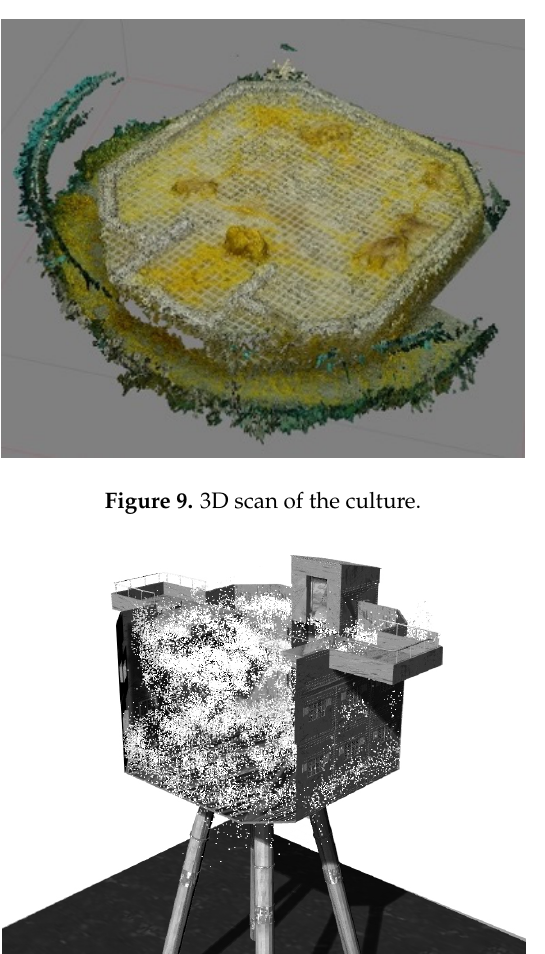
Figure 8. Documentation process of the layers.